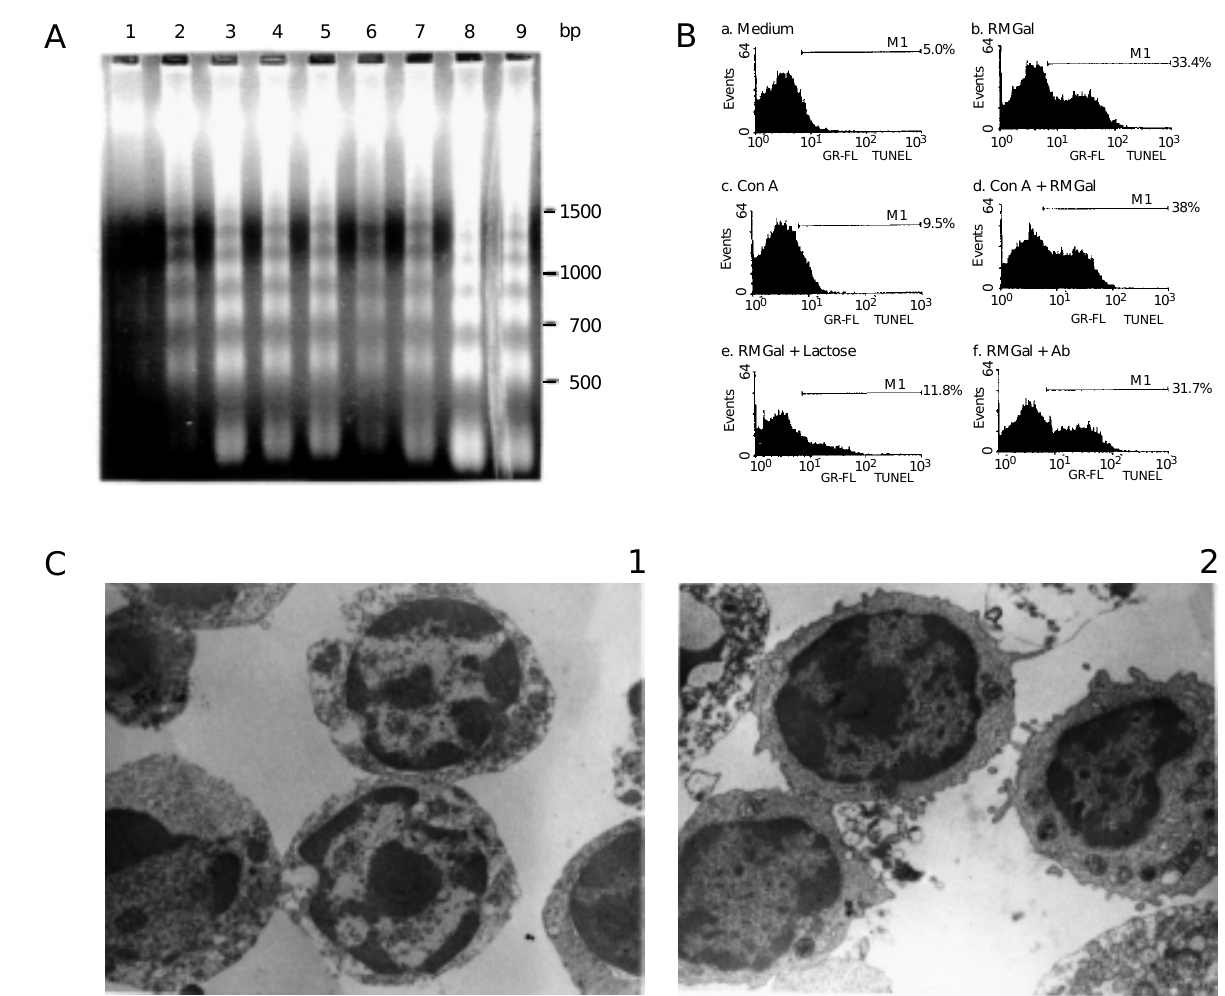
Figure 2 - Rat macrophage galectin induces apoptosis of T cells. A , Electrophoretic analysis of internucleosomal DNA fragmentation induced by RMGal. Spleen mononuclear cells were cultured in 24-well microtiter plates at a density of 2 x 10 7 cells/well for 6 h in medium alone (lane 1), in medium containing Con A, 2.5 µg/ml (lane 2), and in medium containing Con A, 2.5 µg/ml, plus the addition of RMGal at a concentration of 4 µg/ml (lane 3). Cells were also cultured with RMGal (4 and 6 µg/ ml) in the absence of a mitogenic stimulus (lanes 4 and 5, respectively). The T cell-enriched population was purified and cultured under identical conditions in medium alone (lane 6), in medium containing Con A (lane 7), in the presence of Con A plus RMGal, 4 µg/ml (lane 8), and in the presence of RMGal alone, 4 µg/ml (lane 9). Cells were then harvested and genomic DNA was extracted. Samples were diluted in loading buffer and resolved on 1.8% agarose gel. The relative mobility of oligonucleosome-length DNA fragments reflects integer multiples of ~180-200 bp. Molecular standards (100 bp DNA ladder) are indicated on the right. B , Incorporation of biotinylated dUPT by exogenous TdT into DNA strand breaks generated after RMGal treatment. T cells (2 x 10 7 cells/well) were exposed to medium alone (a), 4 µg/ml RMGal (b), 2.5 µg/ml Con A (c), 2.5 µg/ml Con A plus 4 µg/ml RMGal (d), 4 µg/ml RMGal in the presence of 100 mM lactose (e), or 4 µg/ml RMGal in the presence of galectin Ab (f) for 6 h at 37 o C in 5% CO 2 . Samples were harvested, fixed, and permeabilized and the percentage of apoptotic cells in each sample was determined by flow cytometry analysis after TUNEL labeling. Cells treated with DNAse I were used as positive controls. C , Transmission electron microscopy examination of ultrastructural changes induced by RMGal. T cells were purified and cultured in 24-well plates at a density of 2 x 10 7 cells/well, in the presence (1), or in the absence (2) of RMGal (4 µg/ml). After 6 h, cells were harvested, washed and processed for transmission electron microscopy. Galectin-treated cells displayed the typical ultrastructural features compatible with apoptosis. Magnification: X12,000. (From Journal of Immunology , 160: 4831-4840, 1998. Copyright 1998, The American Society of